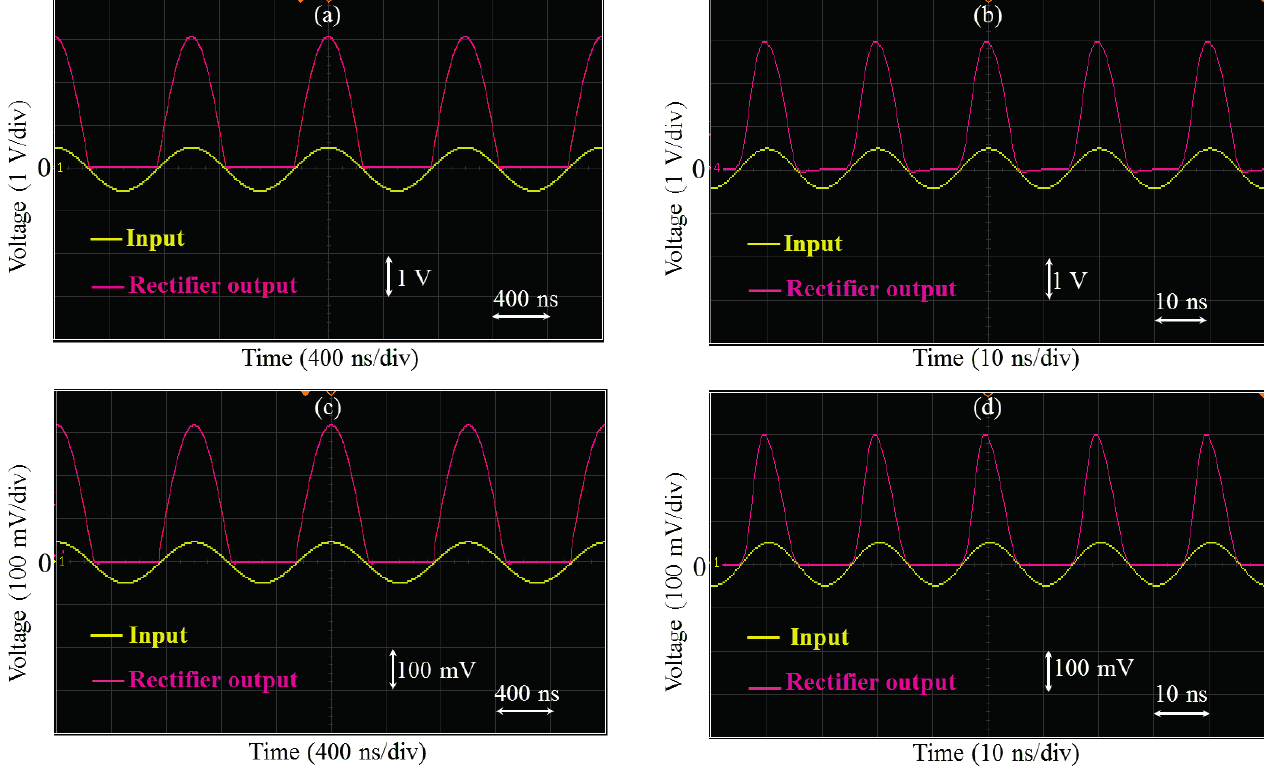
Figure 3. Half wave rectification and amplification of ( a ) 1 MHz/500 mV; ( b ) 50 MHz/500 mV; ( c ) 1 MHz/50 mV and ( d ) 50 MHz/50 mV sine waveforms